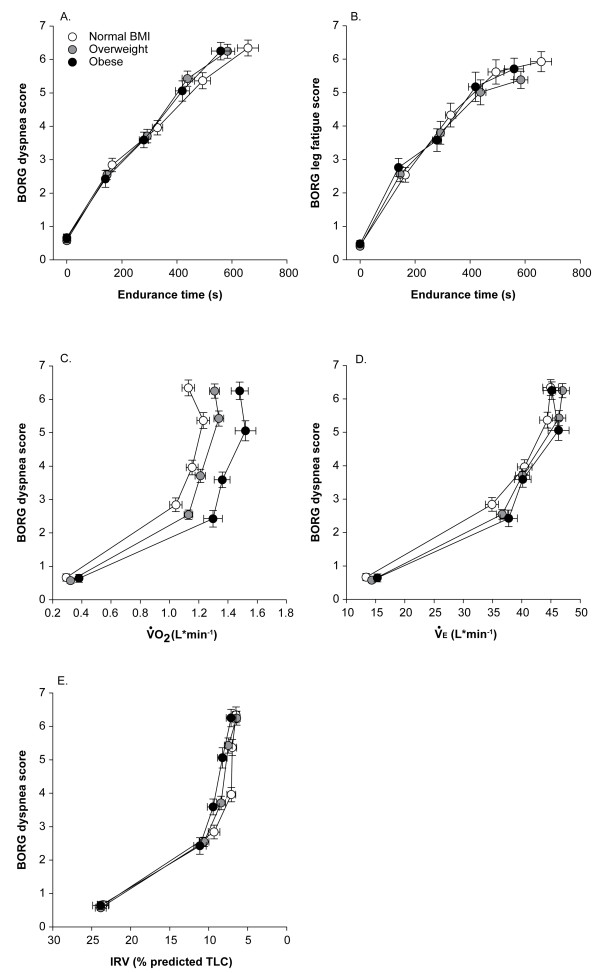
Borg dyspnea (panel A) and leg fatigue (panel B) scores in relation to constant workrate endurance time, Borg dyspnea score in relation to oxygen consumption (VO2, L·min-1, panel C) ventilation (VE, L·min-1, panel D) and inspiratory reserve volume (IRV, % of predicted total lung capacity, panel E). Values are mean ± SE. White filled circles are normal BMI, grey are overweight and black, obese patients.